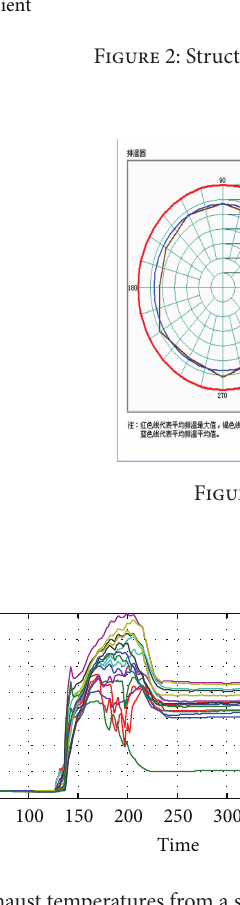
Figure 4: Exhaust temperatures from a set of thermometers.